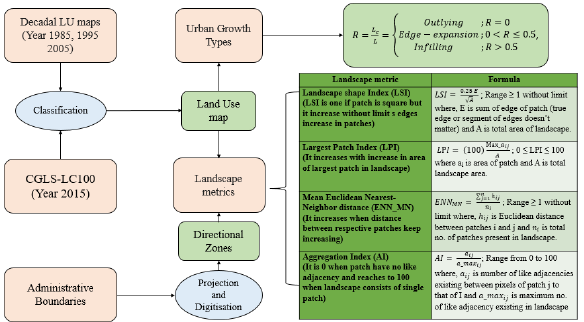
Figure 2 . Flow chart showing methodology used in study.